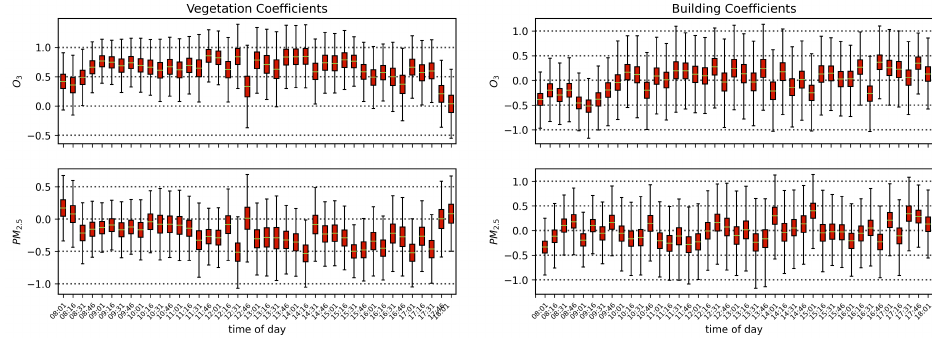
Figure 16. The coefficients for models that only contain O 3 and PM 2.5 concentrations, with tem- perature and absolute humidity absent, for each series of standardized time-of-day Solar-Induced Fluorescence indicator ( SIFi ) for vegetation ( left ) and buildings ( right ).